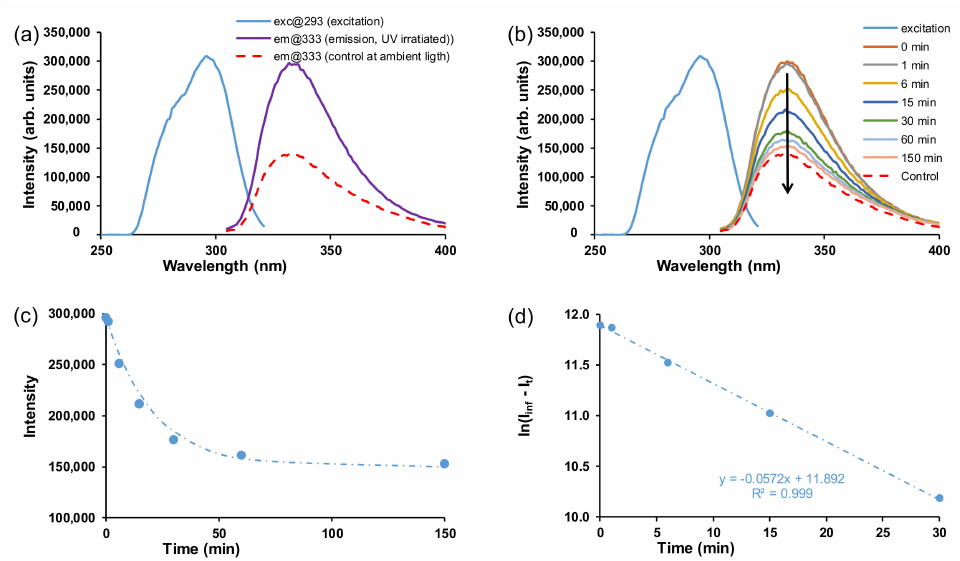
Figure 8. ( a ) Fluorescence spectra of the 10 ppm AZB(COOH) 2 ligand. The excitation curves for both trans and cis overlapped at 293 nm and their emission curves are shown at 333 nm. ( b ) UV-irradiation followed by excitation and decay of the excitation curve under ambient light. ( c ) Intensity (I) vs. time and ( d ) ln(I inf − I t ) vs.